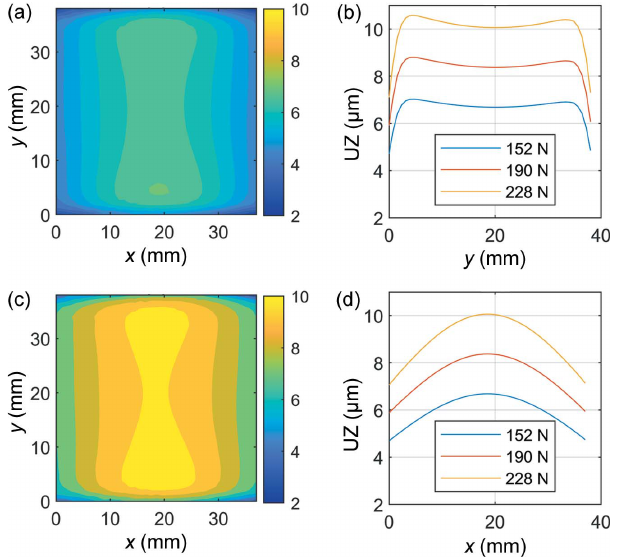
Figure 2 Distortion of the optical surface with ( a ) and ( c ) showing contour plots of maximum total deformation (nm) on the optical surface of the crystal for evenly applied bolt pretensions of 152 N and 228 N, respectively; and ( b ) and ( d ) showing vertical displacement UZ across the centre line of the optical surface of the crystal in the sagittal and meridional directions, respectively.